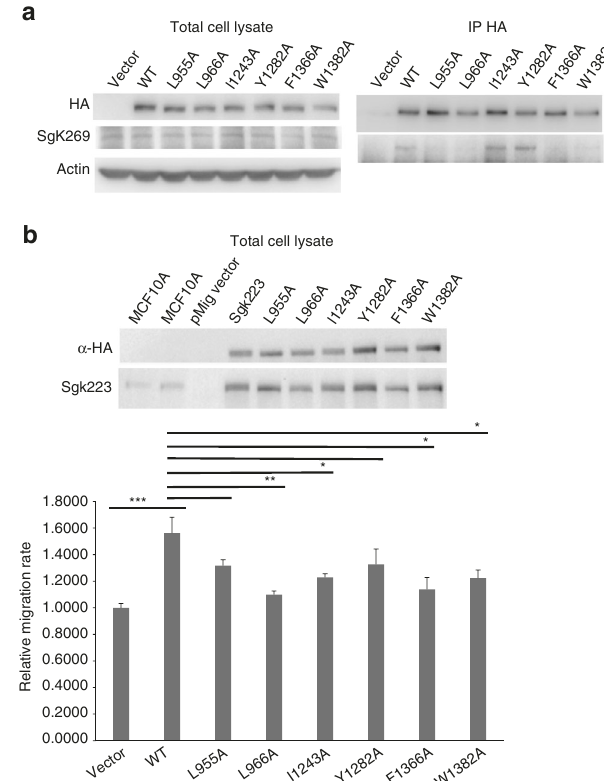
Fig. 8 SgK223-SgK269 heterotypic association in cells and SgK223 function. a Co-immunoprecipitation of exogenous HA-tagged version of FL WT SgK223 or mutant proteins with endogenous SgK269 in MCF-10A SgK223 KO cells. Lysates were subjected to immunoprecipitation with an anti-HA antibody followed by western blotting with anti-HA or anti-SgK269 antibodies as indicated. Total cell lysates were also blotted with these antibodies, as well as for actin as a loading control. The data are representative of two independent experiments. b Effect of interface mutations on SgK223-promoted cell migration. Western blotting of total cell lysates to con fi rm expression levels of SgK223 FL WT and mutants in MCF-10A parental and SgK223 KO cells. Lysates were blotted with the indicated antibodies (top). Effect of SgK223 FL WT and mutants on cell migration in MCF-10A SgK223 KO cells (bottom). Relative wound closure was measured using TScratch software 59 and used to calculate the cell migration rate. This is expressed relative to vector control, which was arbitrarily set at 1.0. Data represent mean ± SEM from four independent experiments. *** p < 0.005 (for comparison of WT to vector), * p < 0.05, ** p < 0.01 (for comparison of mutants to WT). See also